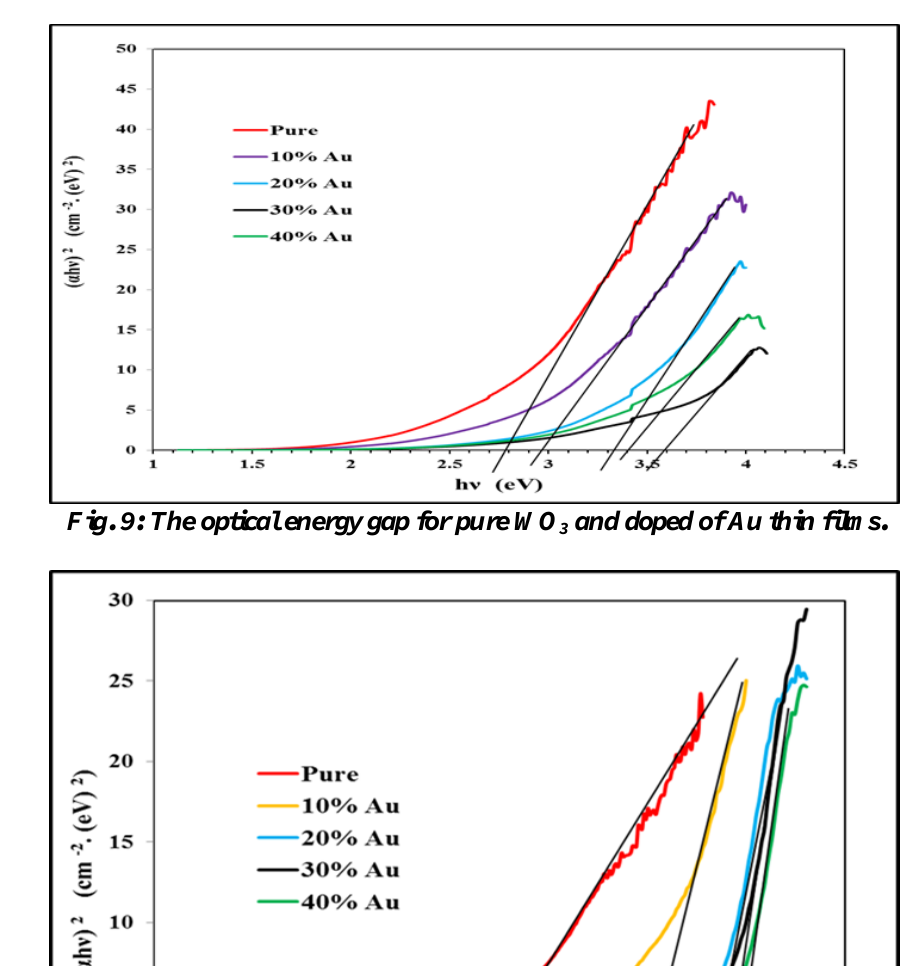
and doped of Au thin films with annealing 3 temperature at T = 400 a